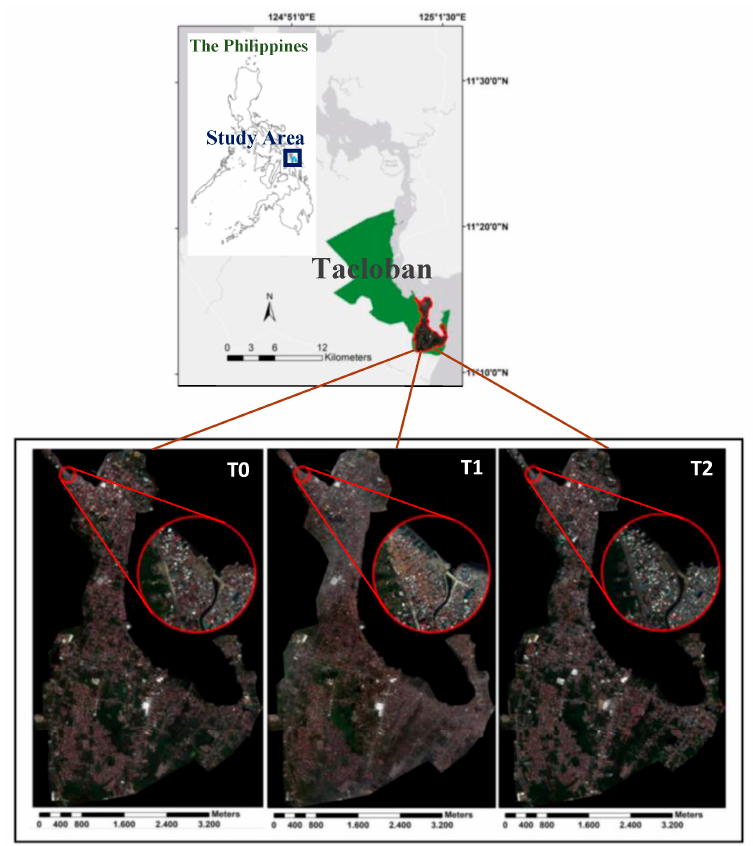
Figure 1. The overview of Tacloban, the Philippines, and the satellite images for the urban area acquired before (T0), 3 days after/event (T1), and 4 years after (T2) typhoon Haiyan. Red circles denote the slum areas in the northern part of Tacloban city, which were devastated by the ty- phoon. Slum areas were detected from three high-resolution WorldView2 satellite images, which were acquired 8 months before (T0), 3 days after (T1), and 4 years after (T2) Haiyan, using our developed machine learning method (Table 1). Table 1. Remote sensing images used in this study.